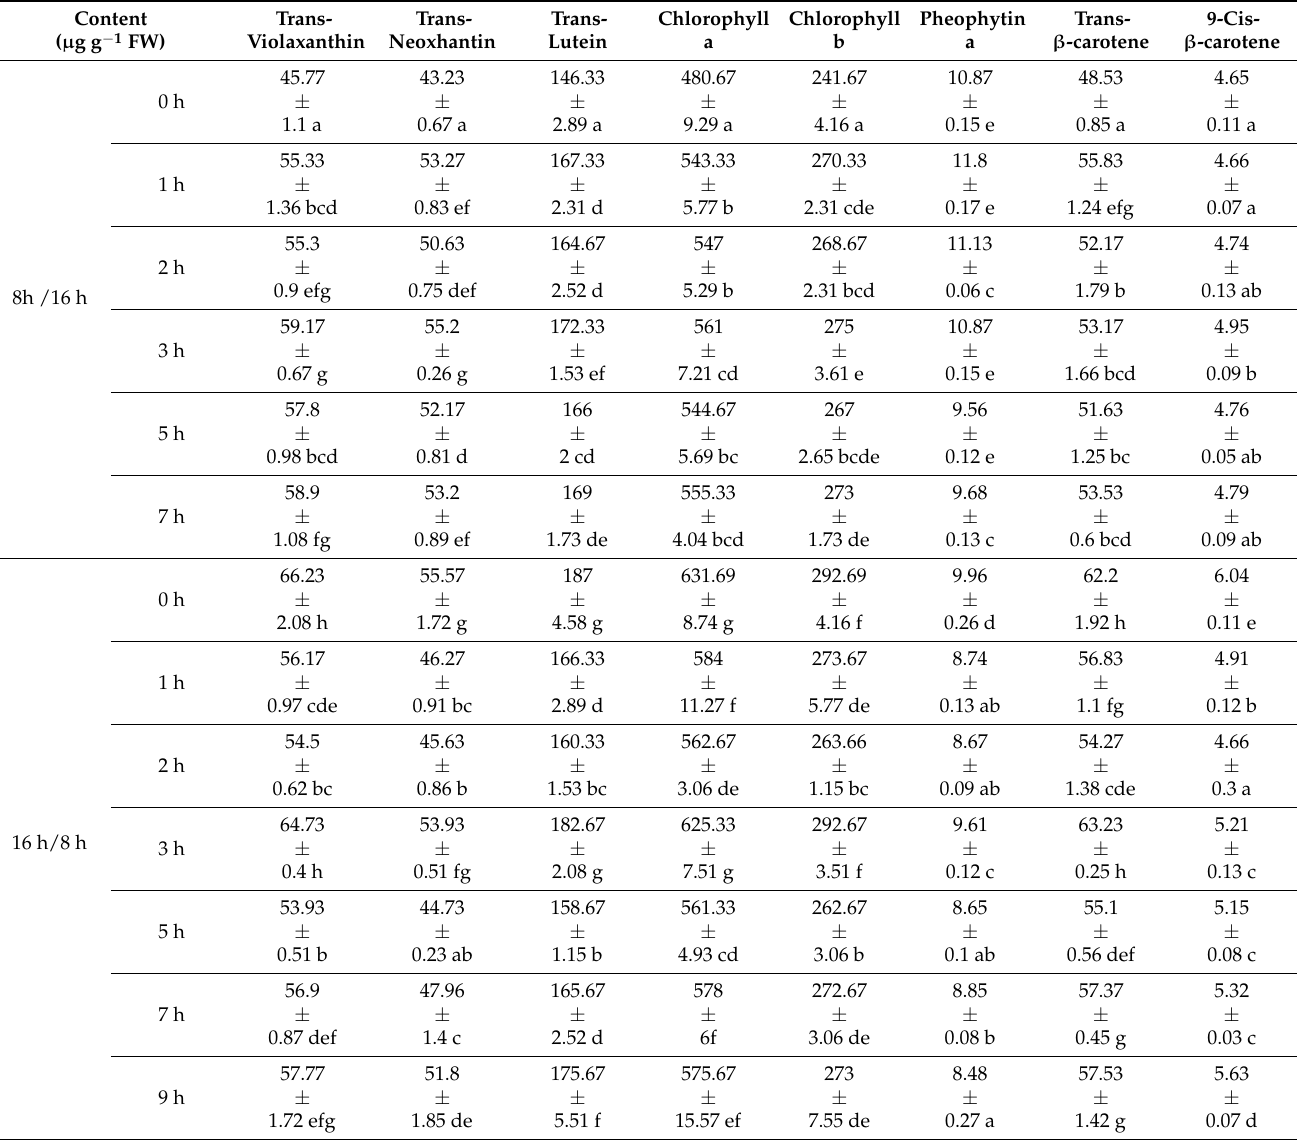
Table 1. Changes in the pigment contents during the illumination period of 7 h or 9 h in plants grown under 8 h/16 h or 16 h/8 h day/night light period. The sampling at 0 h means that plants were sampled in the dark, directly before the onset of the light. Data represent mean values ± SD. Different letters indicate significant differences at p ≤ 0.05 level, among all the values of the given